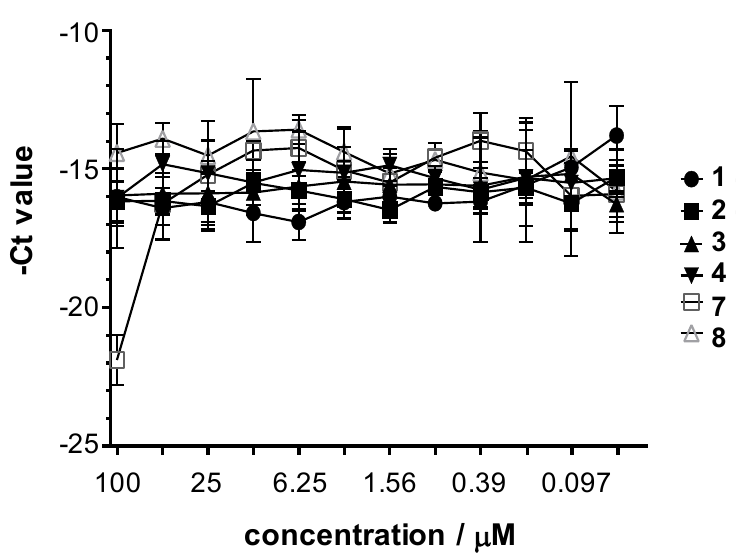
Figure 3. Antiviral effect of complexes 1 – 4 and 7 – 8 against herpes simplex virus-2.